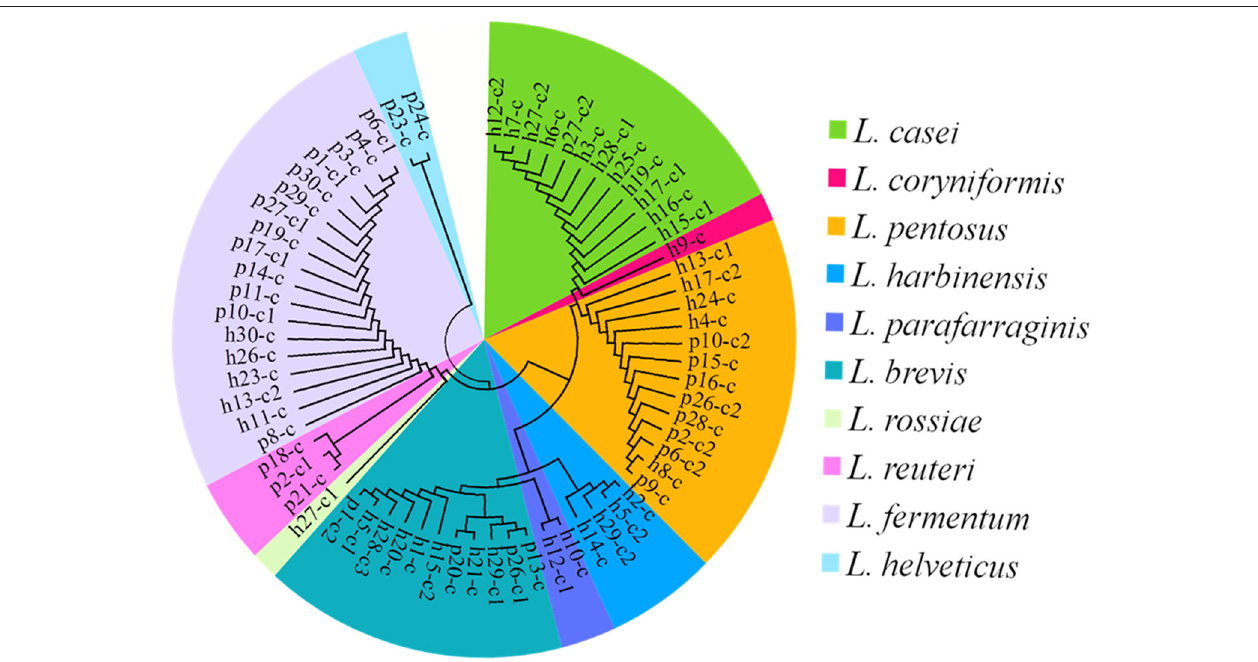
FIGURE 4 | The cladogram tree of the lactic acid bacteria (LAB). The partial 16S rRNA gene sequences (921–925 bp) were analyzed using the Neighbor-Joining method. L, Lactobacillus .